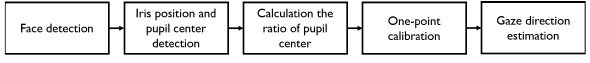
Figure 2. The image processing pipeline for gaze estimation in GaVe.